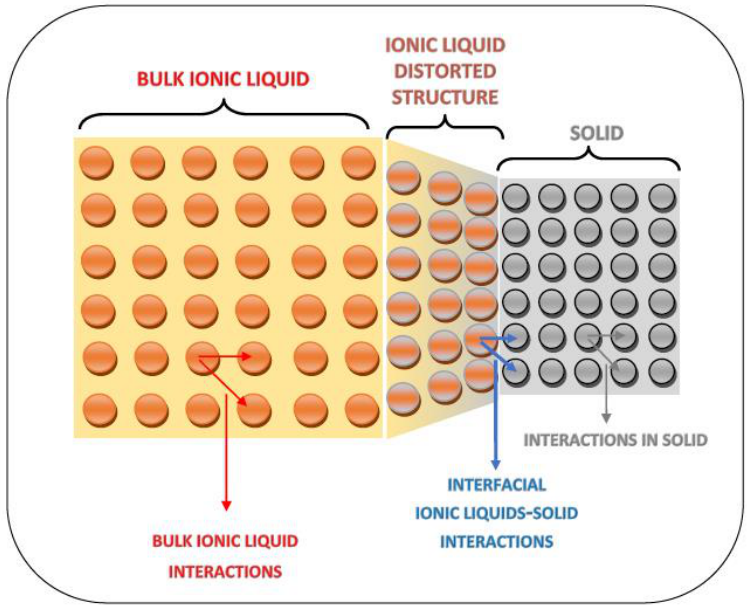
Figure 3. IL structure close to a surface.